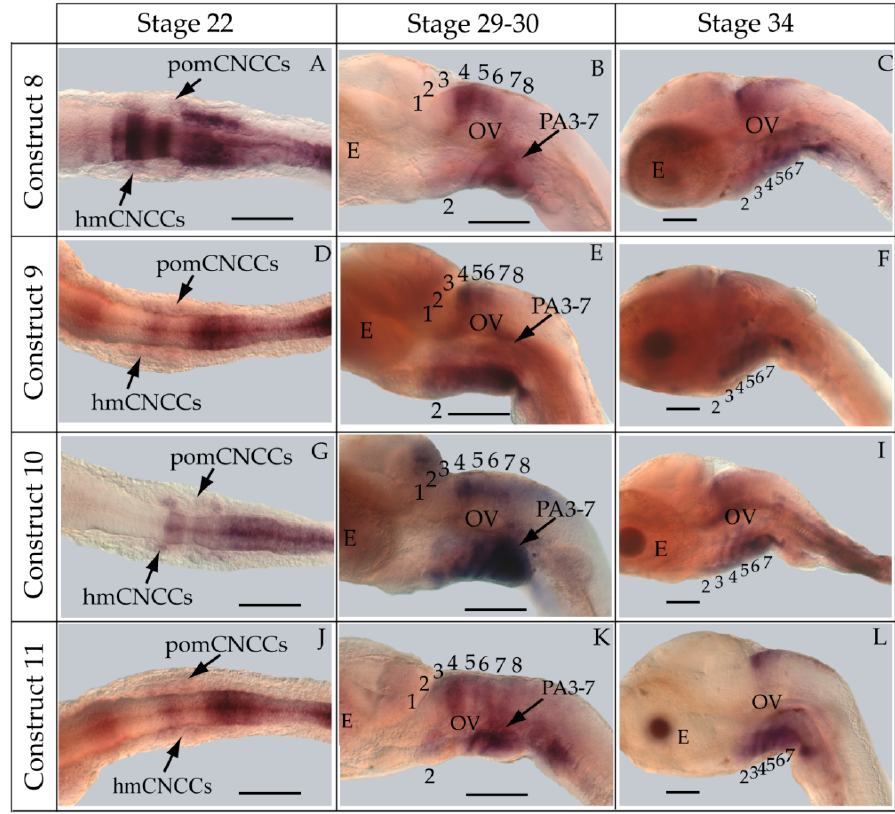
Figure 7. Whole-mount in situ hybridization of eGFP in stable-line ψ hoxa2b UER(K20-RE5) transgenic medaka embryos generated with: Construct #8 ( A – C ); Construct #9 ( D – F ); Construct #10 ( G , H and I ); and construct #12 ( J – L ) at stages 22 (9 s) ( A , D , G , J ); 29/30 (72–84 hpf); ( B , E , H , K ); and 34 (121 hpf) ( C , F , I , L ). ( A , D , G , J ) Embryos were mounted with their anterior sides facing left and their dorsal sides facing the reader. ( B , C , E , F , H , I , K , L ) Embryos were mounted with their anterior sides facing left and lateral sides facing the reader. ( B , E , H , K ) Images are magnified to show rhombomere placement. Rhombomere numbers are indicated by black numbers above the dorsal sides of the embryos. Pharyngeal arches are indicated by black numbers below the ventral sides of the embryos. E, eye; hmCNCCs, hyoid migratory cranial neural crest cells; OV, otic vesicle; PA, pharyngeal arch; pomCNCCs, post-otic migratory cranial neural crest cells. Scale bars equal 0.1 mm.